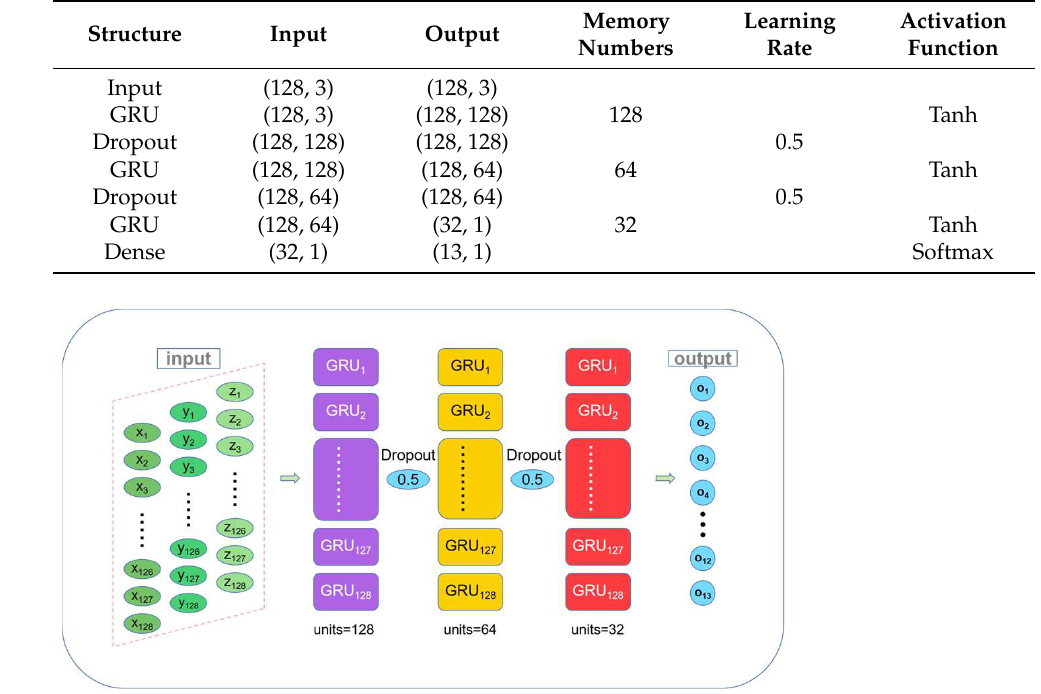
Figure 6. The multi-fault diagnosis network structure.